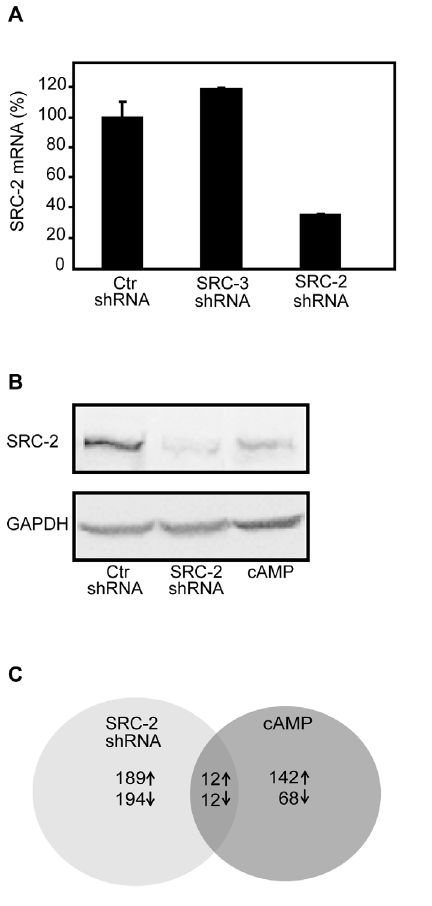
Figure 1. Downregulation of SRC-2 in MCF-7 cells induces distinct changes in global gene expression profiles. (A). Quantification of SRC-2 mRNA expression in shRNA lentivirus-infected MCF-7 cells. mRNA levels of SRC-2 in a MCF-7 cell line infected with shRNA targeting SRC-2 (SRC-2 shRNA) were compared to the expression in a control shRNA MCF-7 cell line (Ctr shRNA), and in a MCF-7 cell line transduced with shRNA lentivirus targeting SRC-3 (SRC-3 shRNA). The mRNA expression of SRC-2 is relative to TBP mRNA. The results are representative of at least three independent experiments. (B). Western blotting analyses of SRC-2-depleted MCF-7 cells. MCF-7 cells